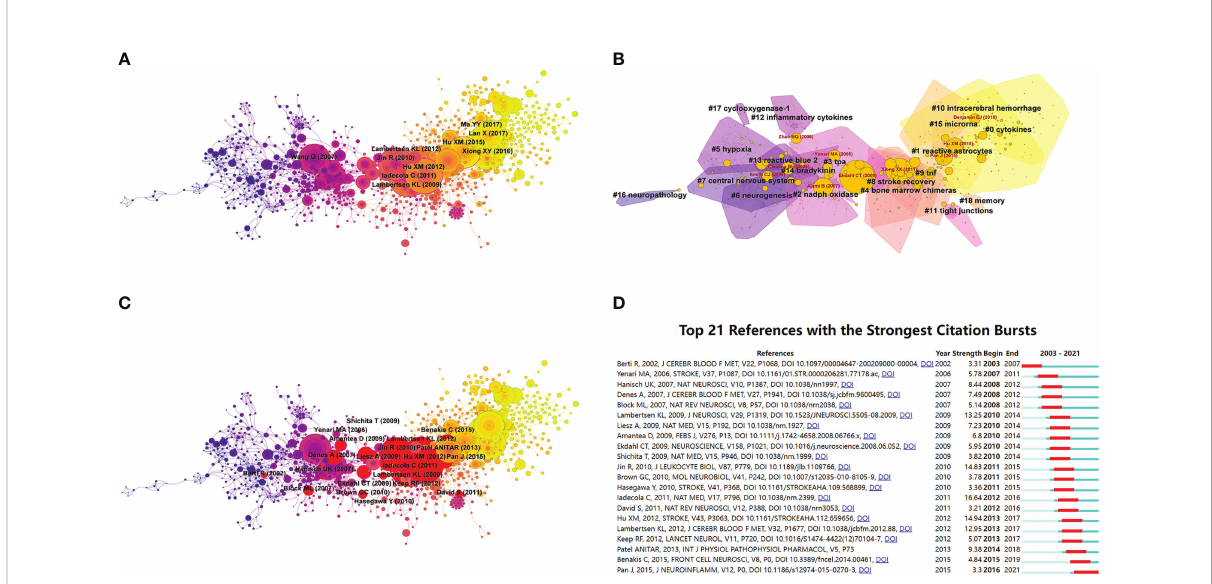
FIGURE 6 Visualization of co-citation and clustering network, where the nodes in the fi gure represent citations and the links between nodes represent co- citation relationships. (A) Co-citation analysis of references; (B) Clustering network analysis of references; (C) Burst detection of co-citations, where red represents bursts; (D) Burst detection of top 21 references, where red bars indicate burst